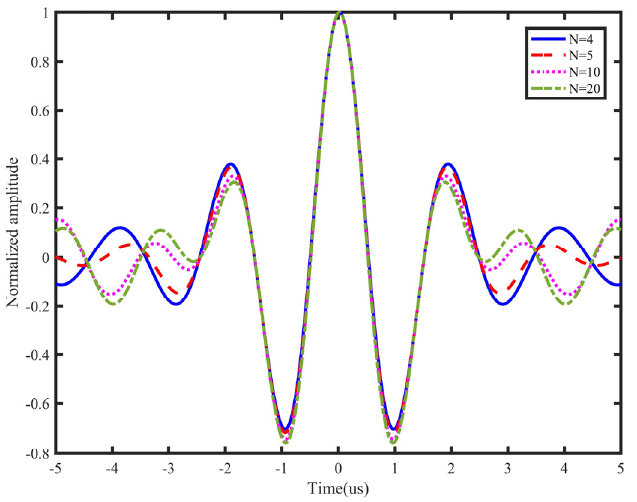
Figure 3. Autocorrelation curves of L-Chirp signals with different cycles.